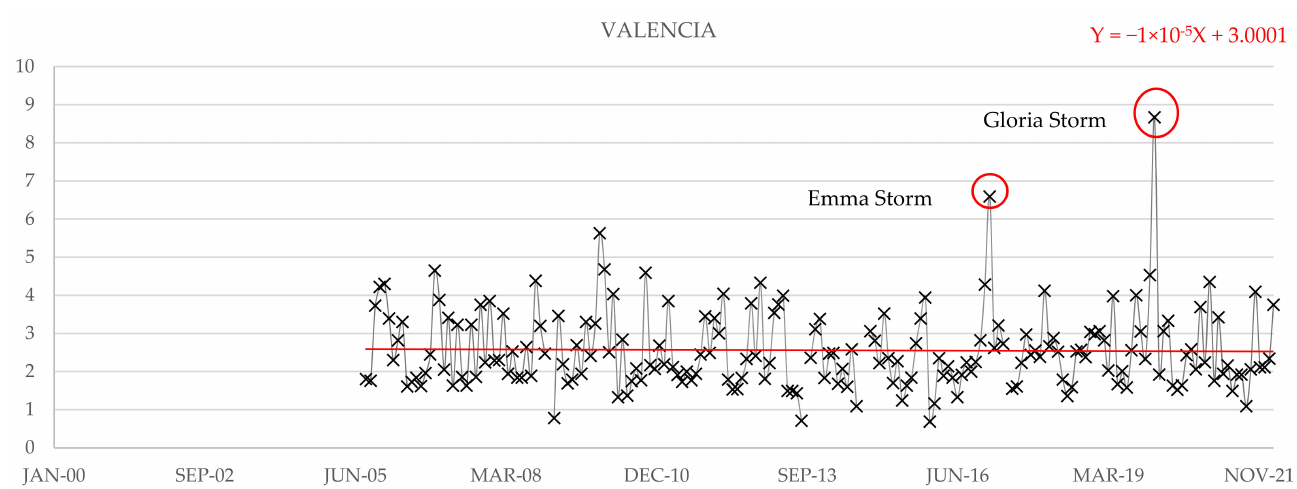
Figure 6. Evolution of Hs maxima in Cabo de Palos.